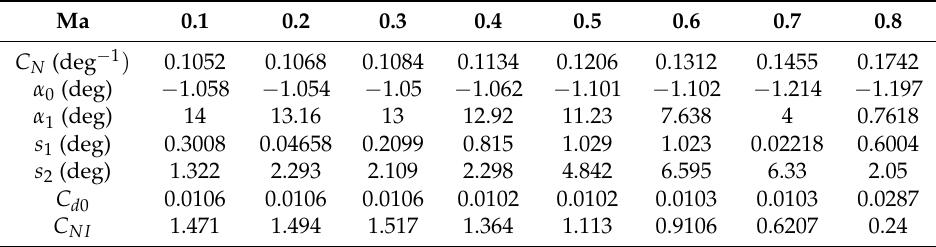
Figure 3. NACA23012 dynamic stall validation. Table 1. NACA23012 static stall